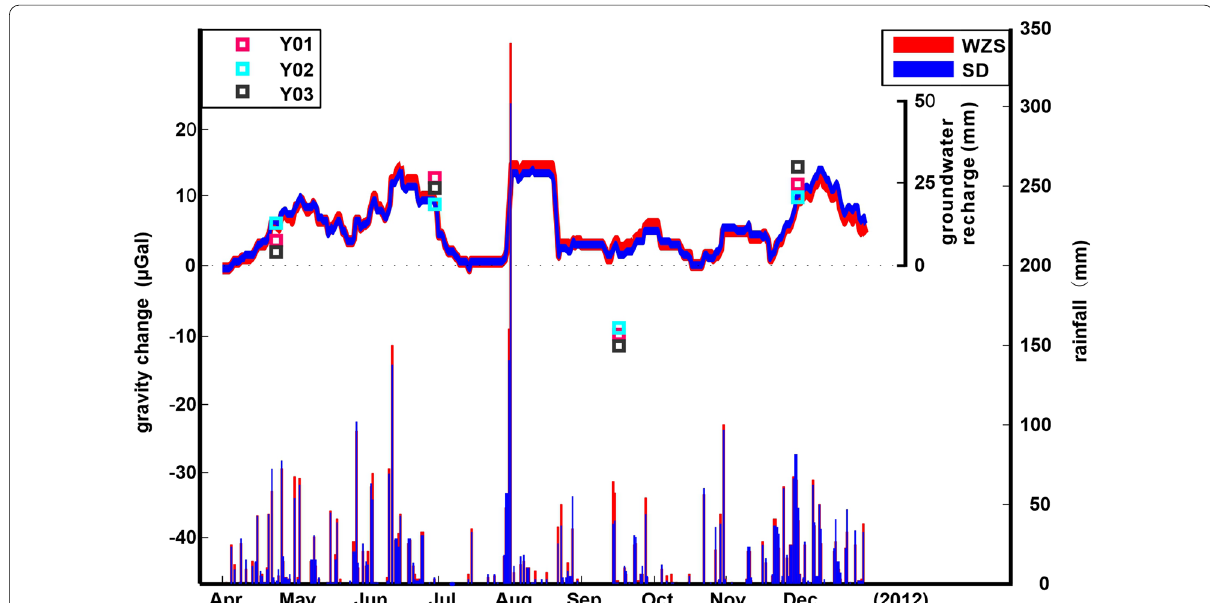
Fig. 3 Gravity changes and rainfall. Red and blue bars show rainfalls recorded at stations WZS and SD and the resulting groundwater recharge. Red, cyan, and black squares show gravity changes at Y01, Y02, and Y03. The station locations are indicated in Fig. 1. Typhoon Saola traversed northern Taiwan from July 31 to August 3, bringing heavy rainfall to the